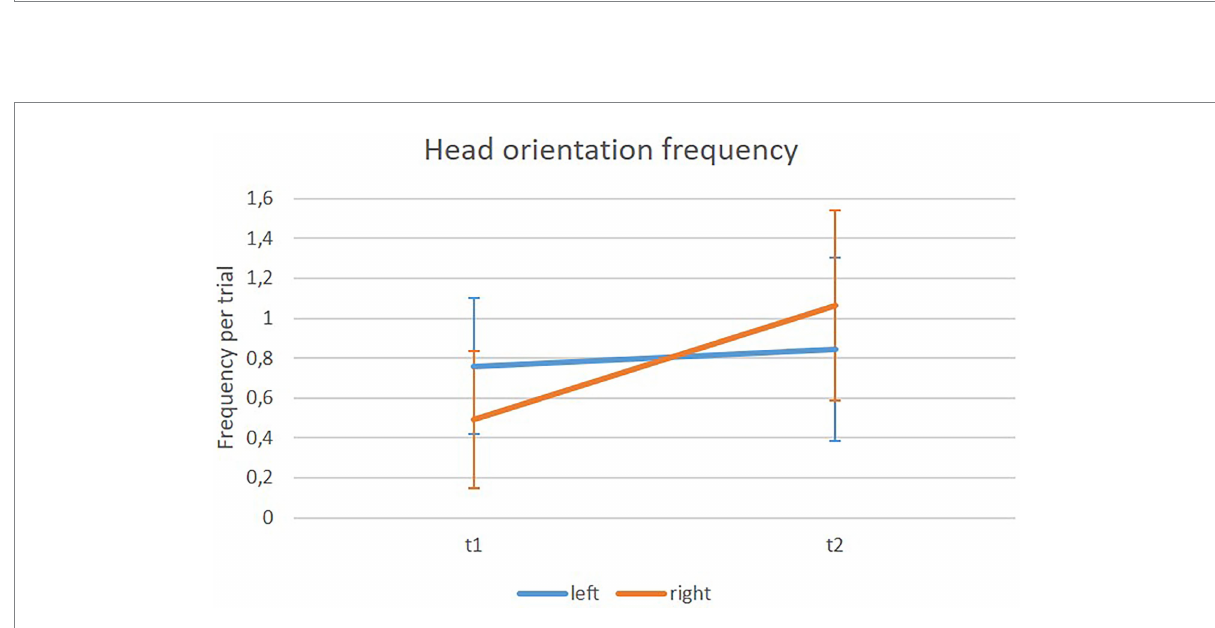
FIGURE 10 Means of frequencies of different orientations of head rotation in the field experiment on the footpath (t1) and on the street